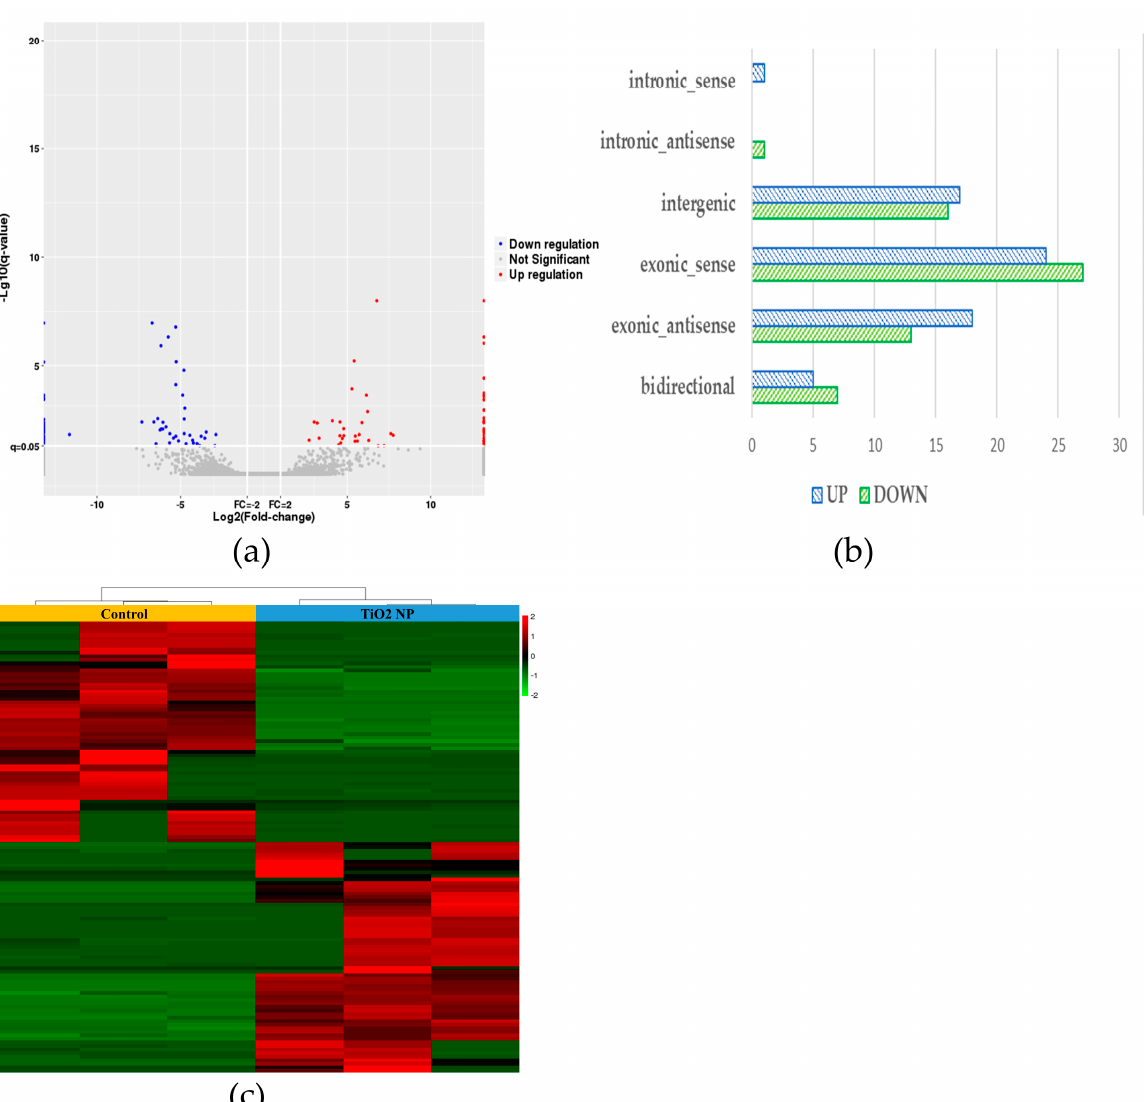
Figure 5. lncRNA differential expression analysis of TiO 2 NPs with concentrations of 0 and 100 μ g/mL. A volcanic map of differentially expressed genes in the treatment group showed the number of up-regulated and down-regulated genes ( a ). The histogram of the relative expression of differential lncRNAs was drawn and showed that the lncRNAs belonging to the exonic-sense class counts had the highest proportion ( b ). A heat map of cluster analysis between the treatment group and control group demonstrated their characteristic difference ( c ).